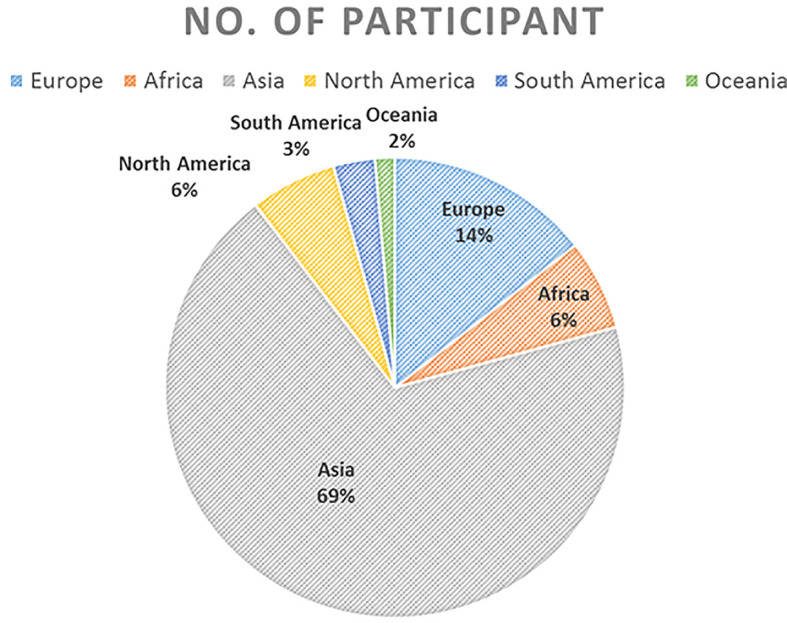
Number of participating planners by continent and overall.